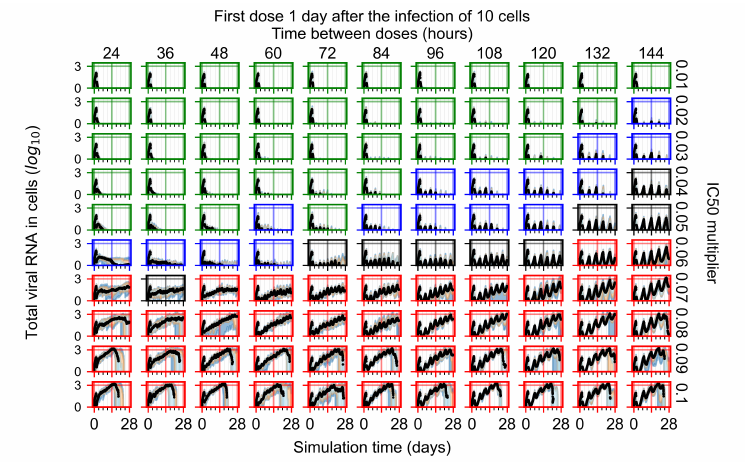
Figure A28. Amount of viral RNA in infected cells (arbitrary units), Y axis in log scale, and exponent values as tick